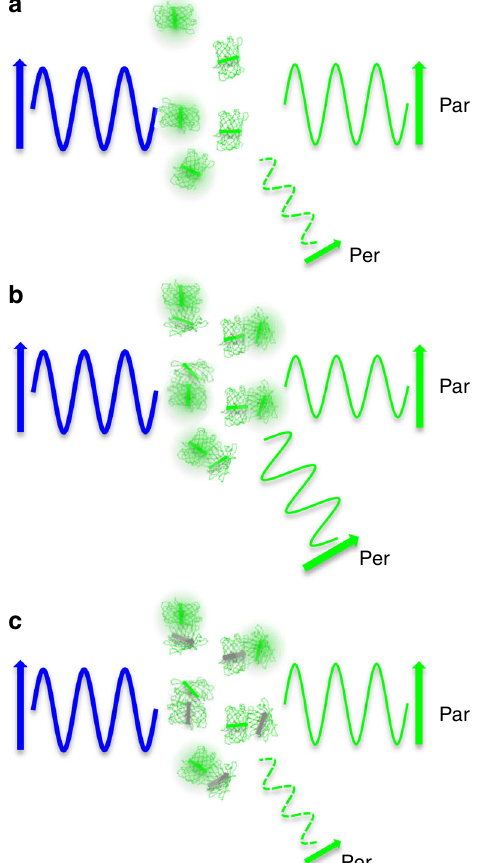
Fig. 1 Principle of photoswitching anisotropy FRET. a Illumination of a population of sparse, non-interacting fl uorescent protein molecules with polarized light (shown in blue) will lead to preferential excitation of molecules with dipoles oriented with the excitation polarization. The subsequent fl uorescence emission (shown in green) detected in channels selectively fi ltered for parallel (par) or perpendicular (per) polarized light will produce a characteristic parallel to perpendicular ratio. b If the molecules are bound together close enough to homo-FRET, the molecules preferentially excited with polarized blue light can transfer their excited state energy to molecules which have dipoles randomly oriented with respect to the excitation polarization. This leads to an increase in perpendicular polarized emission at the expense of parallel polarized emission. c Fluorescent molecules in a complex which are photoswitched off or photobleached become unable to accept energy from an excited partner and the parallel to perpendicular ratio